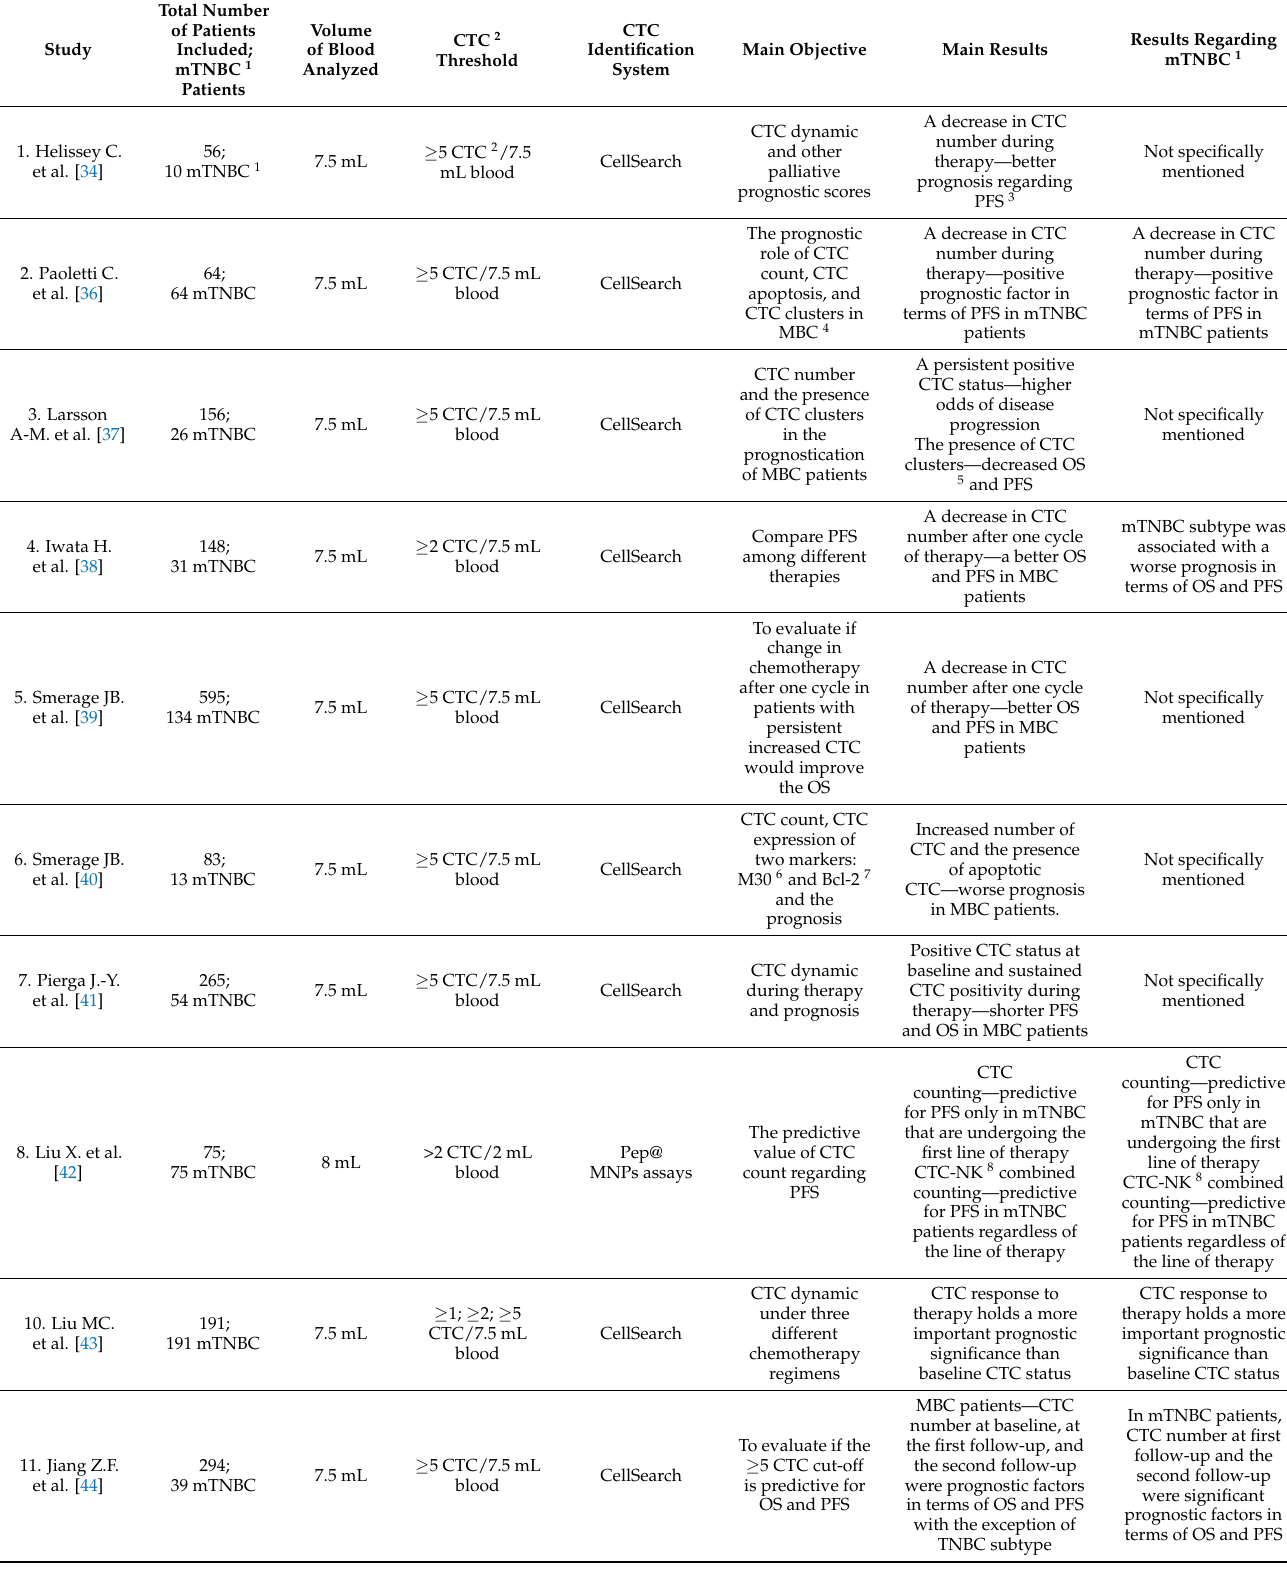
Table 3. The impact of therapy upon circulating tumor cells in mTNBC 1 : number of patients, volume of blood, CTC 2 threshold, technology used for their characterization, and main